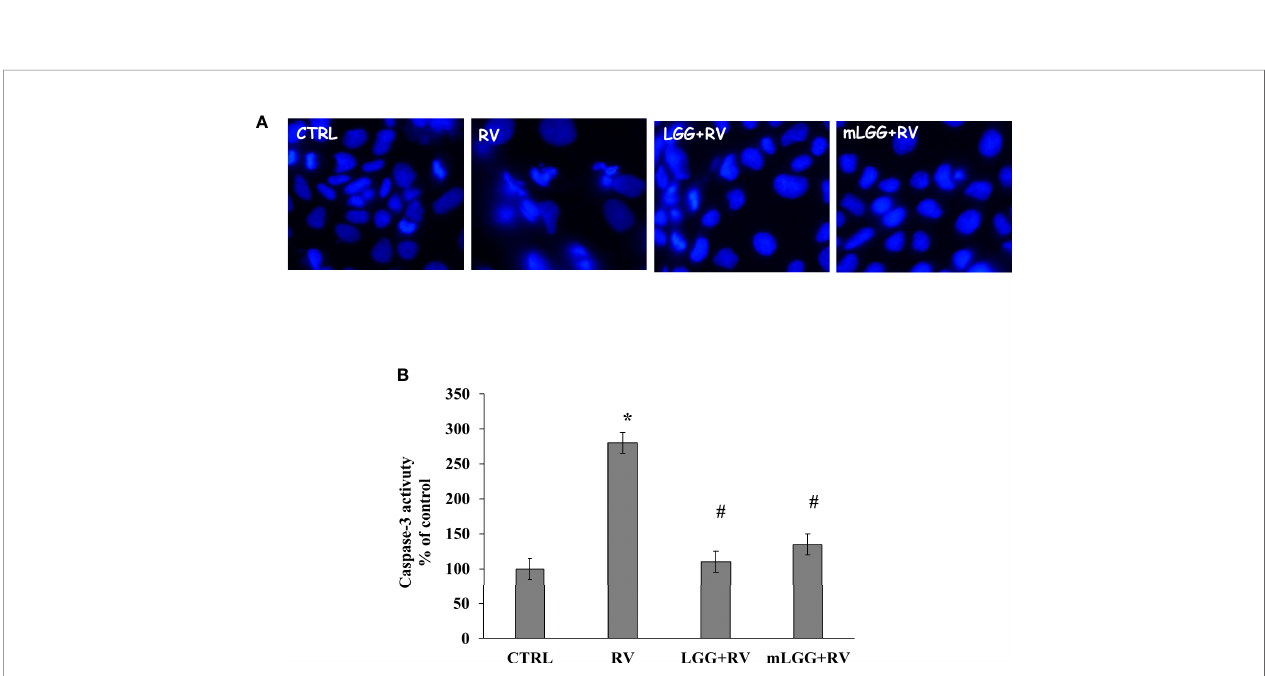
FIGURE 4 | Effect of LGG on apoptosis induced by RV. (A) Apoptotic nuclei were evaluated in Caco-2 cell monolayers infected with RV preincubated with LGG or mLGG as described in the Methods Magni fi cation: 400X. (B) Caco2 cells were infected with RV following preincubation in the absence of LGG or mLGG and caspase-3 activity as apoptotic marker was evaluated as described in Methds [*p < 0.05 vs CTRL; # p < 0.05 vs